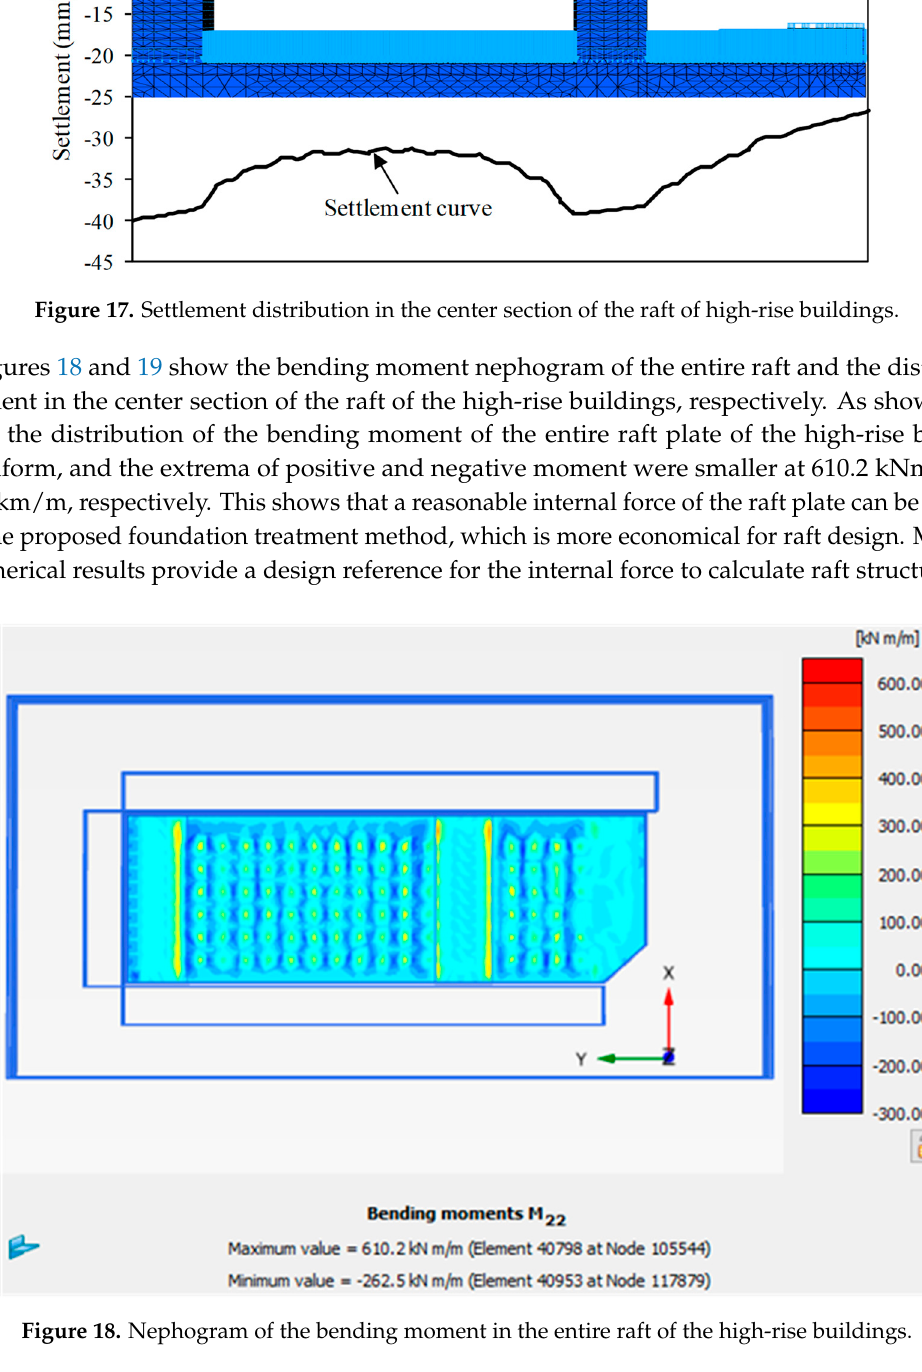
Figure 16. Settlement nephogram in the raft of high-rise buildings.